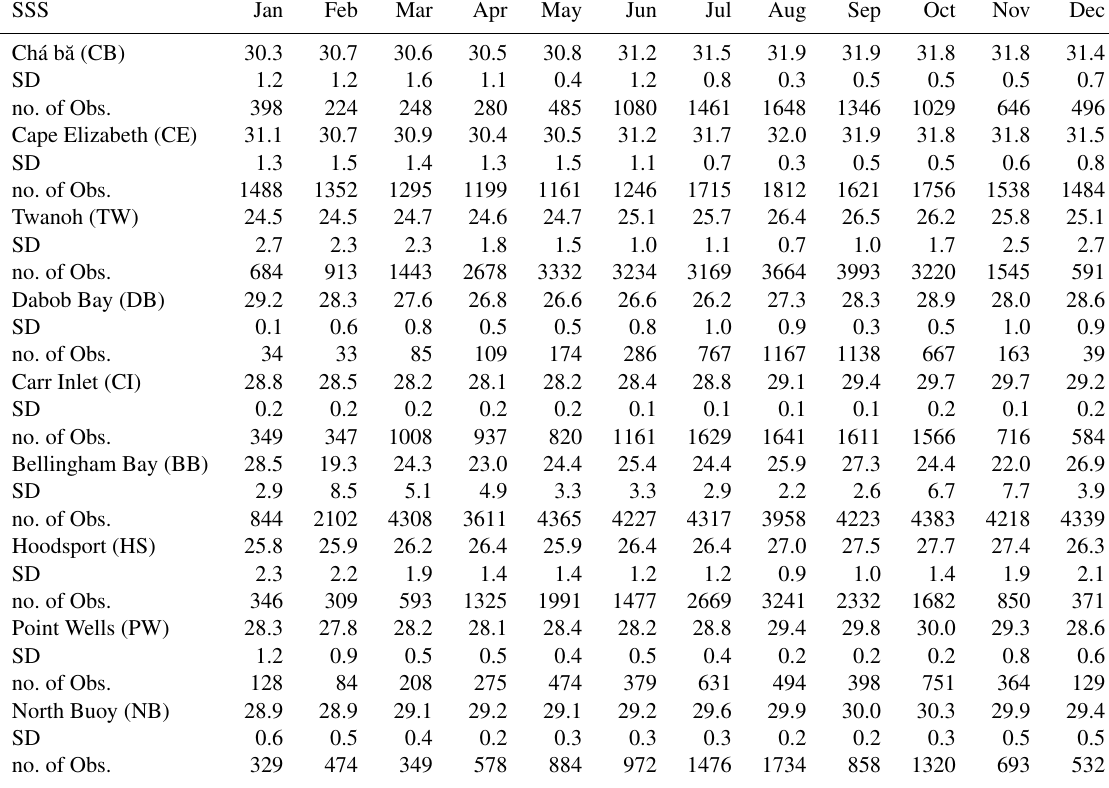
Table C1. Average monthly SSS seasonal cycles for the nine Washington State moorings. The average monthly standard deviation (SD) and total number of observations (no. of Obs.) contributing to the monthly average estimate are included. SSS